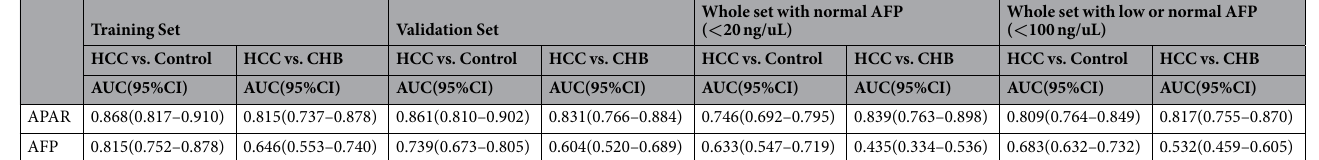
Table 4. Comparison of AUC between APAR and AFP for predicting HCC from non-cancer control or CHB